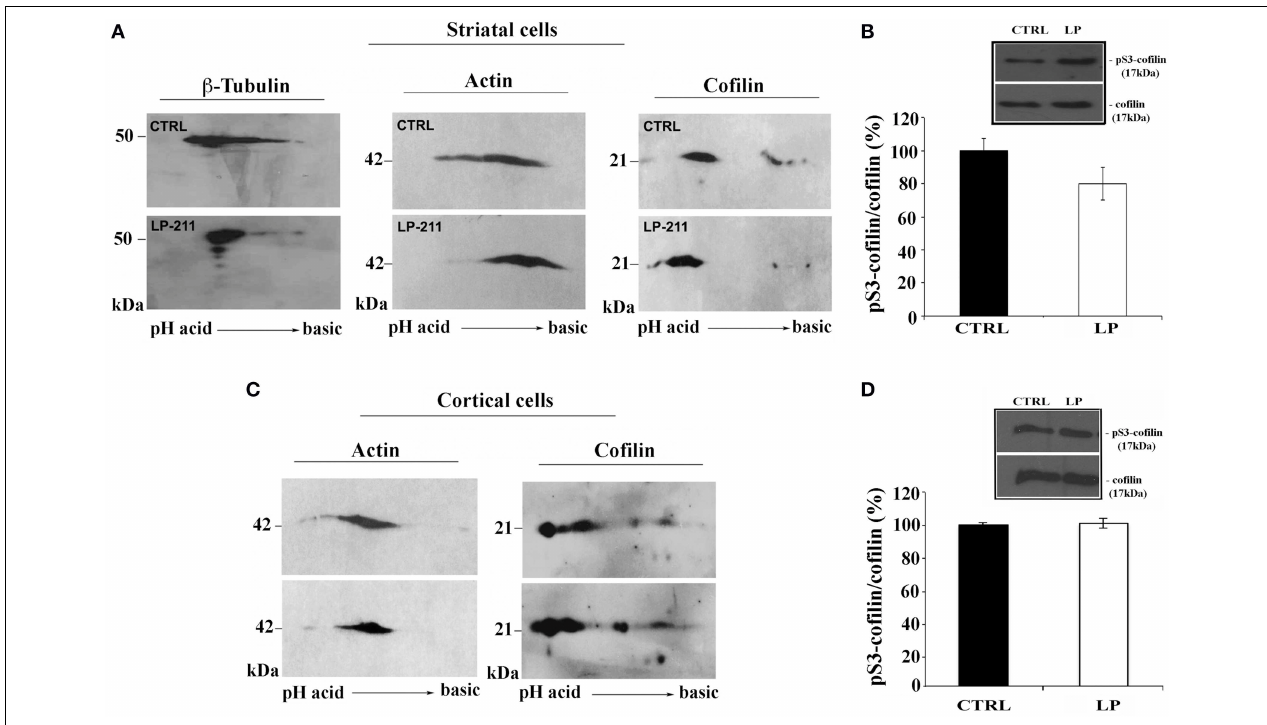
neurons treated for 2h with LP-211 (LP, 100nM). The intensity of pS3-cofilin was normalized with that of total cofilin (means ± SEM; n = 3 ) and was expressed as percentage of values measured in the corresponding vehicle-treated cultures (CTRL, set to 100%). The insets display representative SDS-PAGE blots probed with antibodies against pS3-cofilin and cofilin. The molecular weights (kDa) are indicated on the